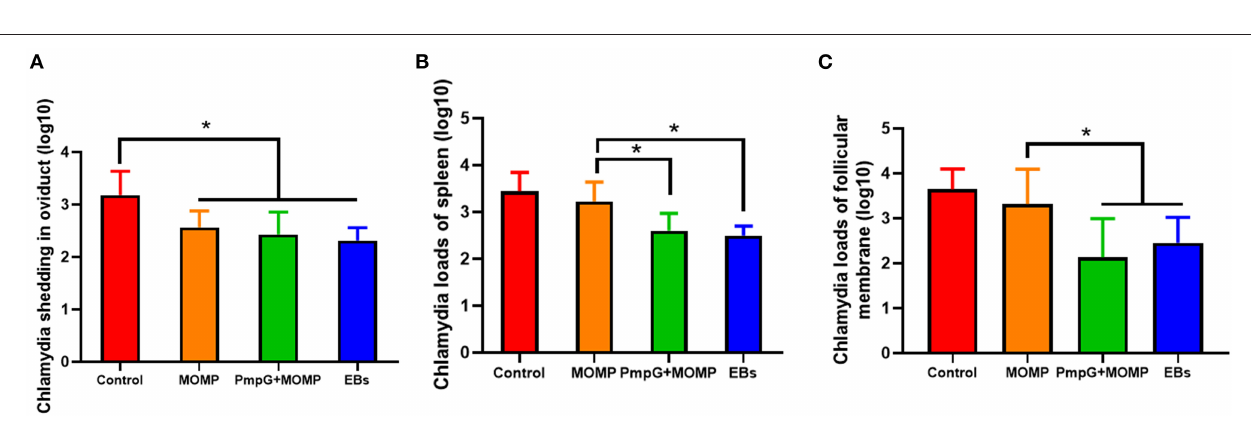
FIGURE 9 | Chlamydial loads and shedding in genital tract of breeder ducks. (A) No significant difference of Chlamydial shedding in the oviduct of breeder ducks was detected among the three tested groups. (B) Less Chlamydial loads of spleens were determined in the PmpGs + MOMP group and the inactivated EBs group compared with the commercial MOMP vaccine or the control group ( p < 0.05). (C) Chlamydial loads of follicular membranes were significantly decreased in the PmpGs + MOMP group and the inactivated EBs group in comparison with the commercial MOMP vaccine and the control group ( p < 0.05). The differences were analyzed by ANOVA (* p <